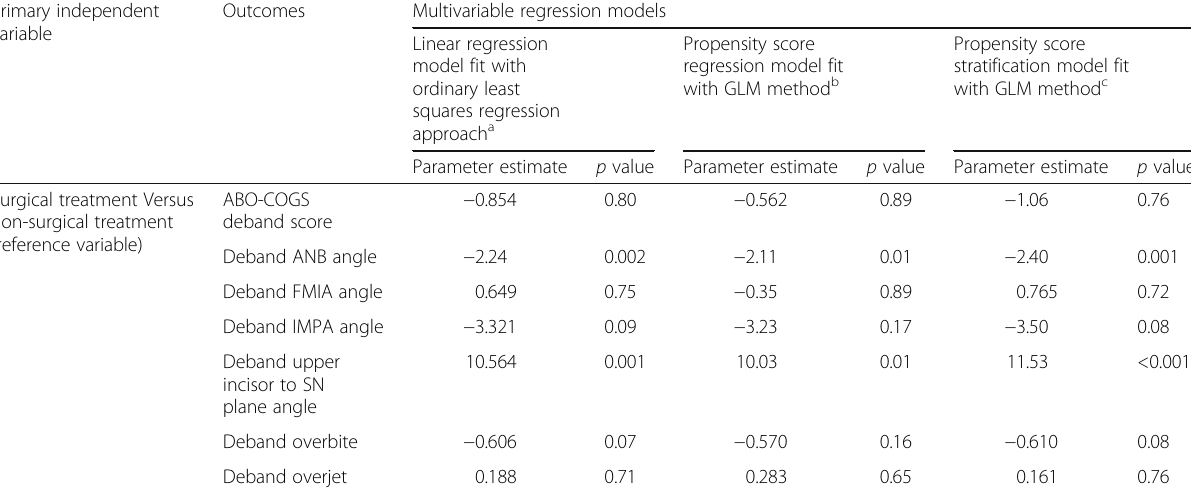
Table 4 Estimates of lateral cephalometric outcomes from multivariable regression models Primary independent